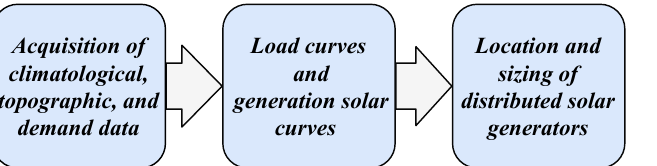
Figure 3. Stages of a project for the optimal location and sizing of distributed generators in distribu- tion